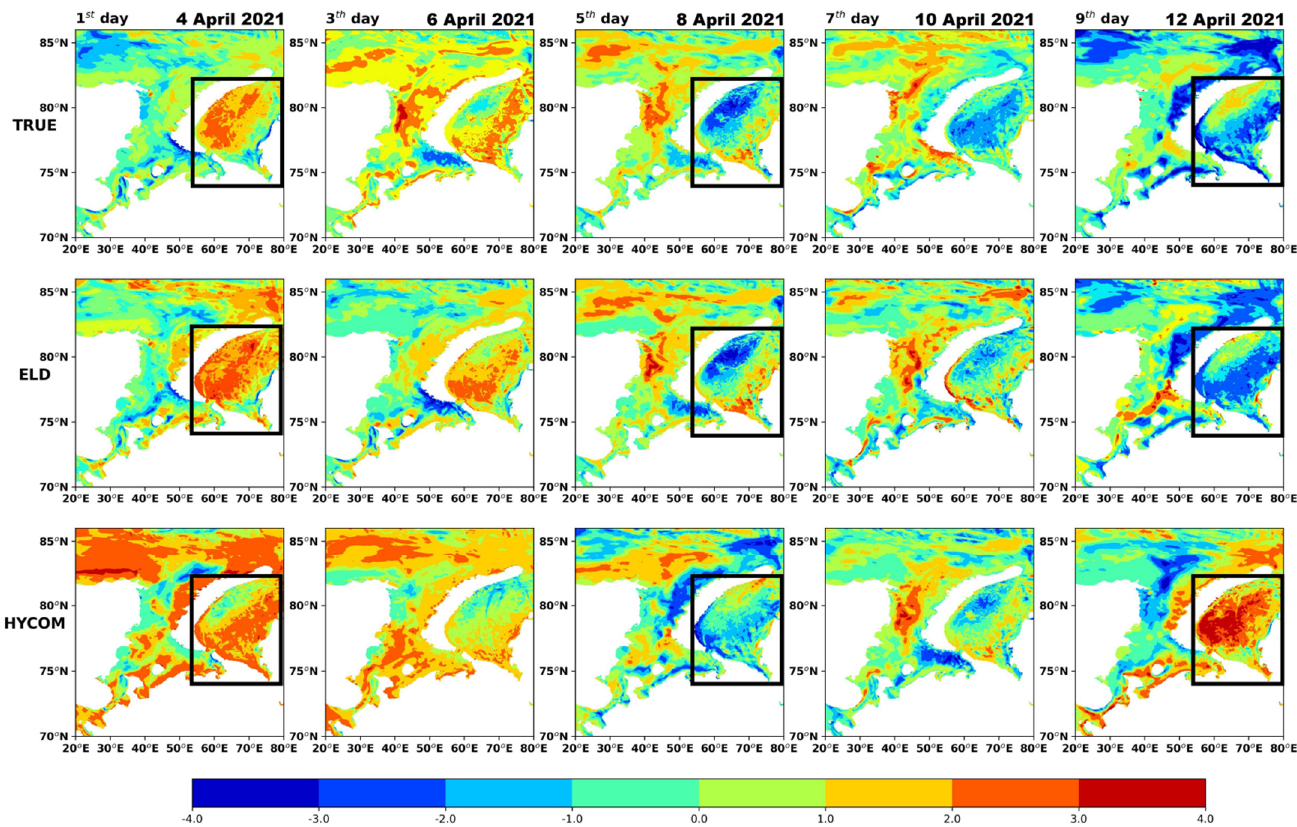
Figure 10. Comparison of forecast results between ELD forecast model and HYCOM numerical forecast model, days 1 to 9 in 2021 from 4 April to 12 April.